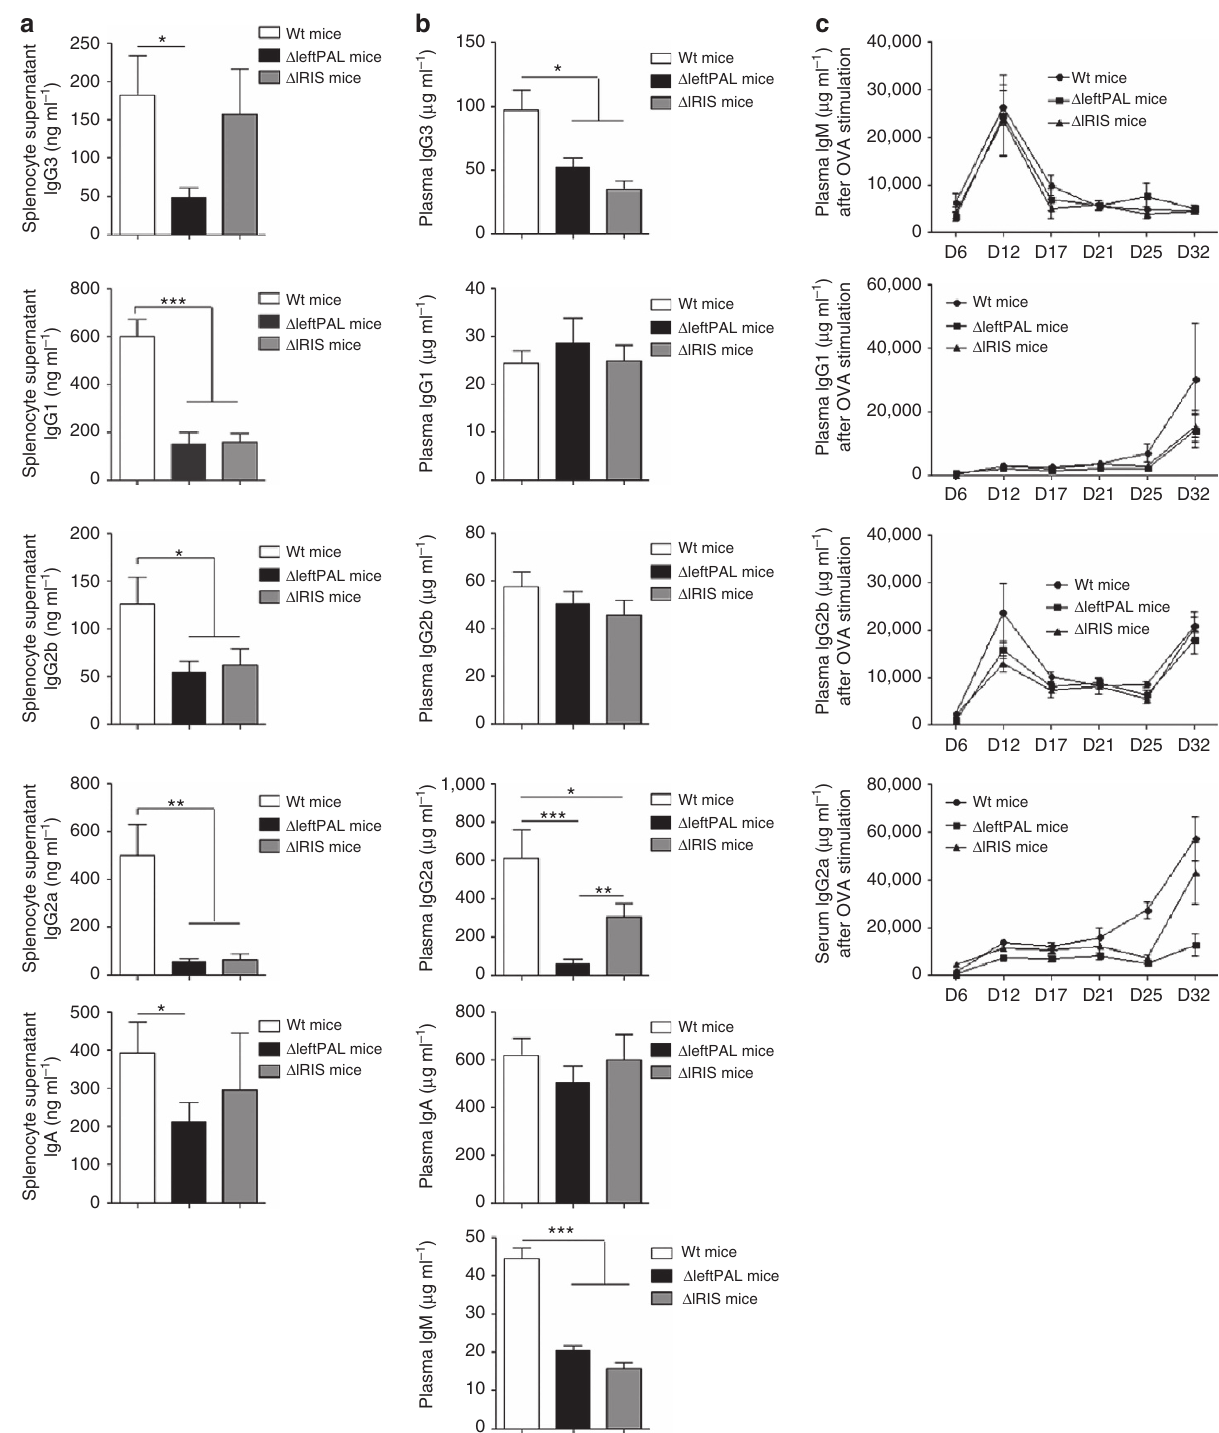
Figure 7 | Influence of the 3’RR palindrome on Ig synthesis. ( a ) ELISA analysis of IgG 1 , IgG 2a , IgG 2b , IgG 3 and IgA in supernatants of LPS ± IL-4-, INF g - and TGF b -stimulated splenocytes of D leftPAL, D IRIS and wt mice. Data are the mean ± s.e.m. of eight experiments with one mouse (8–12 weeks old, male and female). * P o 0.05, ** P o 0.01 and ** P o 0.001 (Mann–Whitney U -test for significance). ( b ) ELISA analysis of IgM, IgG 1 , IgG 2a , IgG 2b , IgG 3 and IgA in plasma of 10 D leftPAL, 9 D IRIS mice and 18 wt mice (8 weeks old, male and female). Mean ± s.e.m. * P o 0.05, ** P o 0.01 and ** P o 0.001 (Mann–Whitney U -test for significance). ( c ) Ovalbumin-specific IgM, IgG 1 , IgG 2a and IgG 2b . Antibody levels, detected by ELISA, are expressed in arbitrary units by comparison with control plasma values. Time after immunisation is indicated in days. Each point is the mean ± s.e.m. of plasma determinations from six mice for each genotype (8–12 weeks old, male and female). One representative experiment out of two is shown.